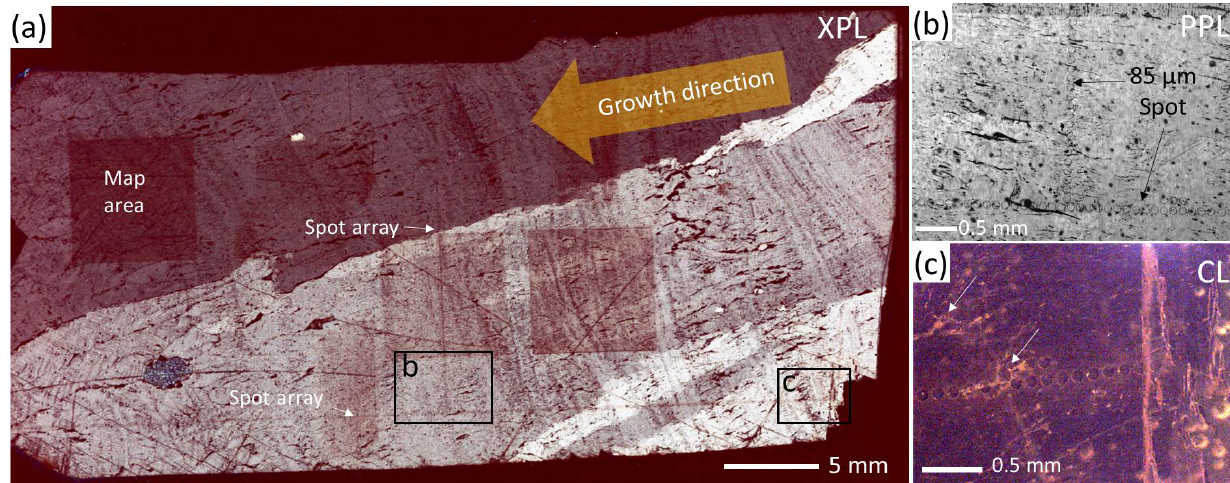
Figure 2. ASH-15D-E thin section. (a) Cross-polarized (XPL) scan, 36mm long, showing continuous growth (no hiatus) and consistent growth direction (indicated with yellow arrow). Spot analyses are targeted either sub-parallel to growth zone or sub-parallel to growth direction; (b) close-up of spot array analyses (location is shown in a ) with 85µm diameter; (c) CL image showing no luminescence except for some bright luminescence within grains boundaries and veins